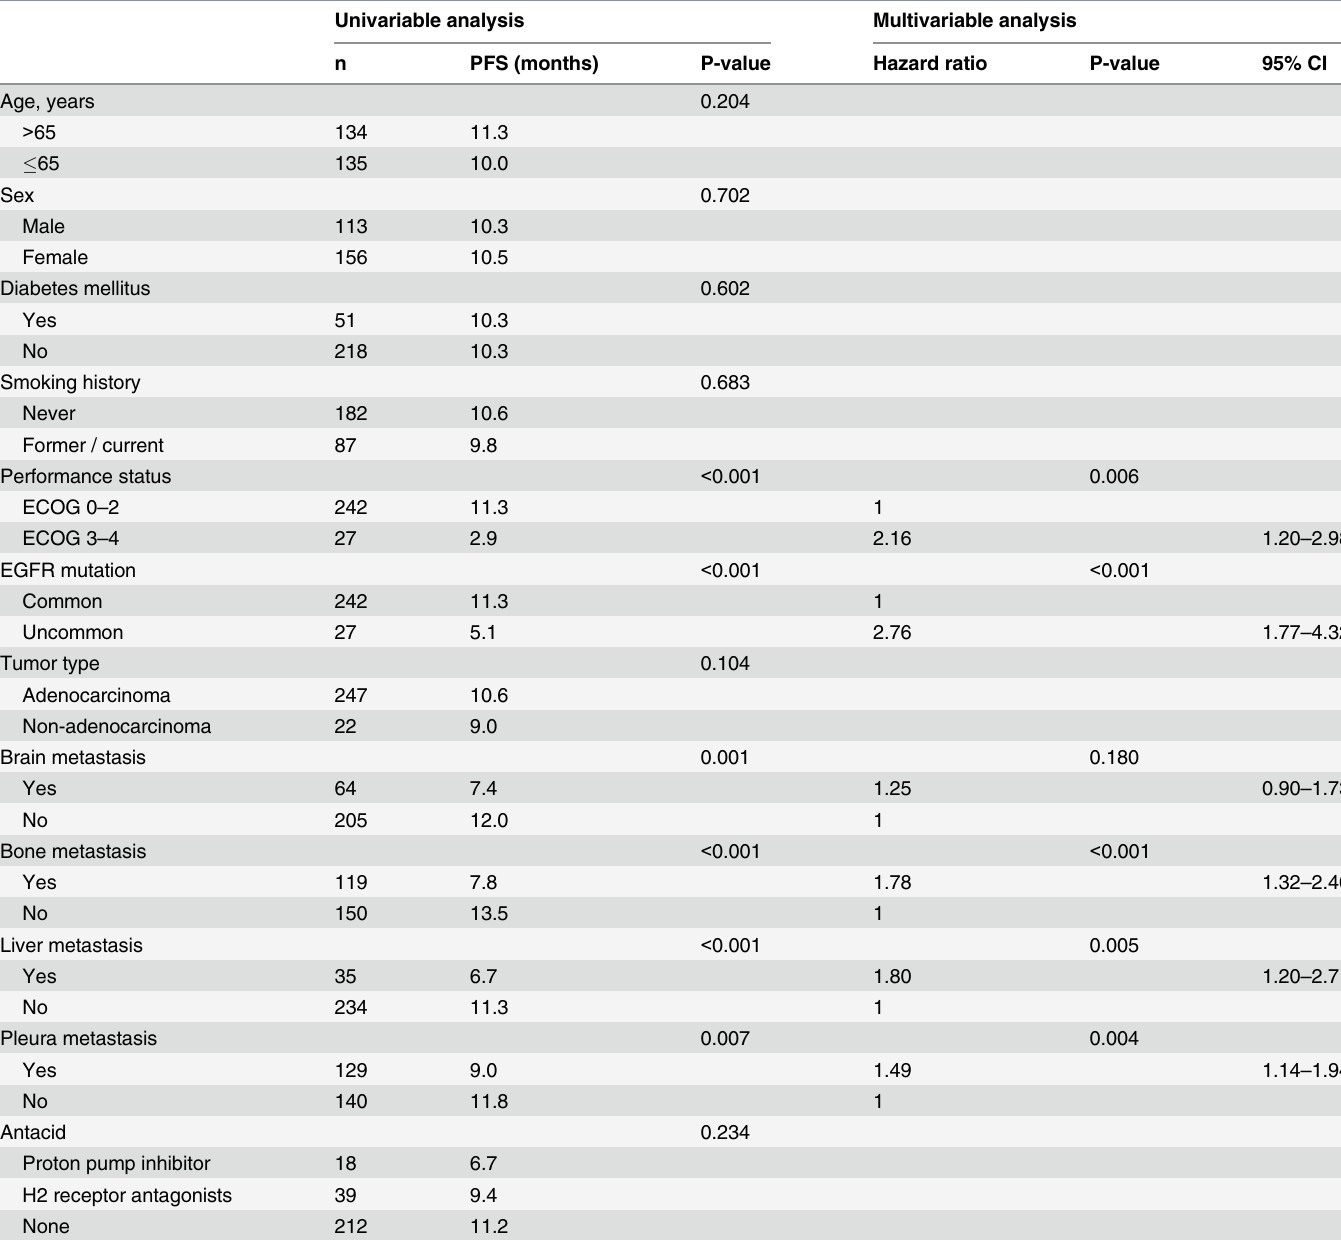
(Table 2). Age, sex, diabetes mellitus, smoking, tumor histology, and antacid use (Fig 2) were Table 2. Univariable and multivariable analysis of progression-free survival. Univariable analysis Multivariable